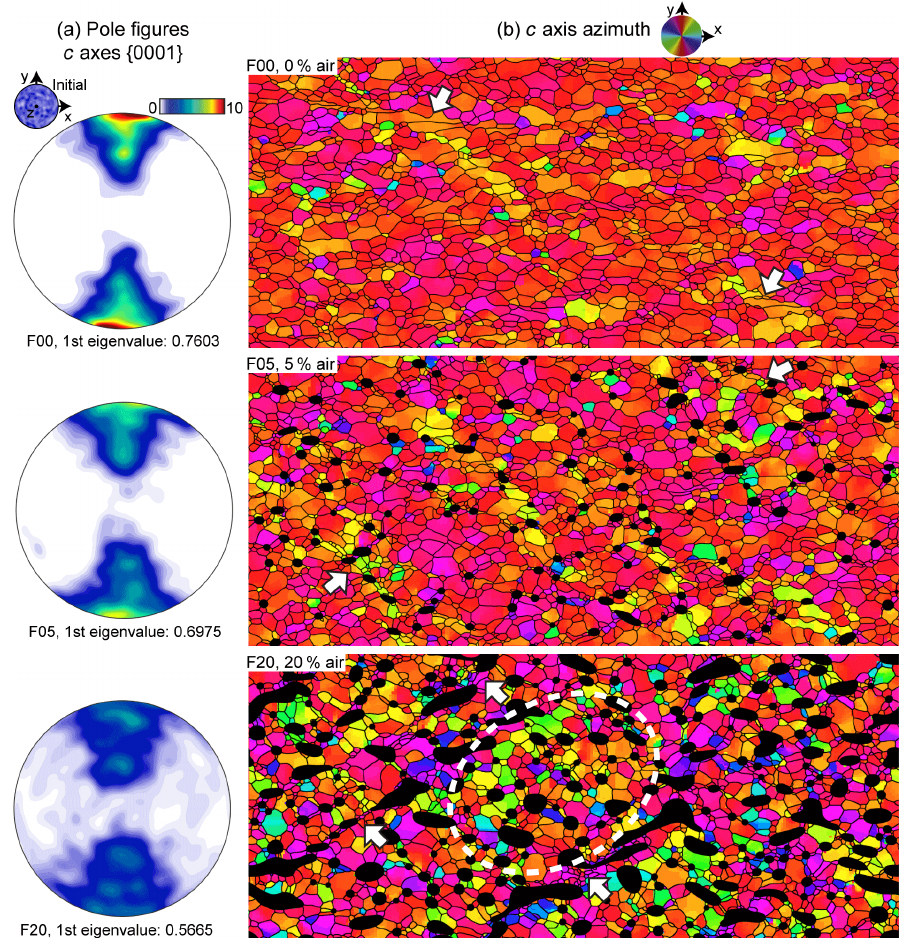
Figure 7. Overview of c axis orientations at 53% vertical shortening for all simulations. (a) Pole figures with the projection plane parallel to the x − y plane of the 2-D model. (b) Maps of c axis azimuth distributions. Air inclusions are shown in black. White arrows in both images indicate zones of marked strain localization. Dotted white line indicates zone of low strain where more random crystallographic orientations are